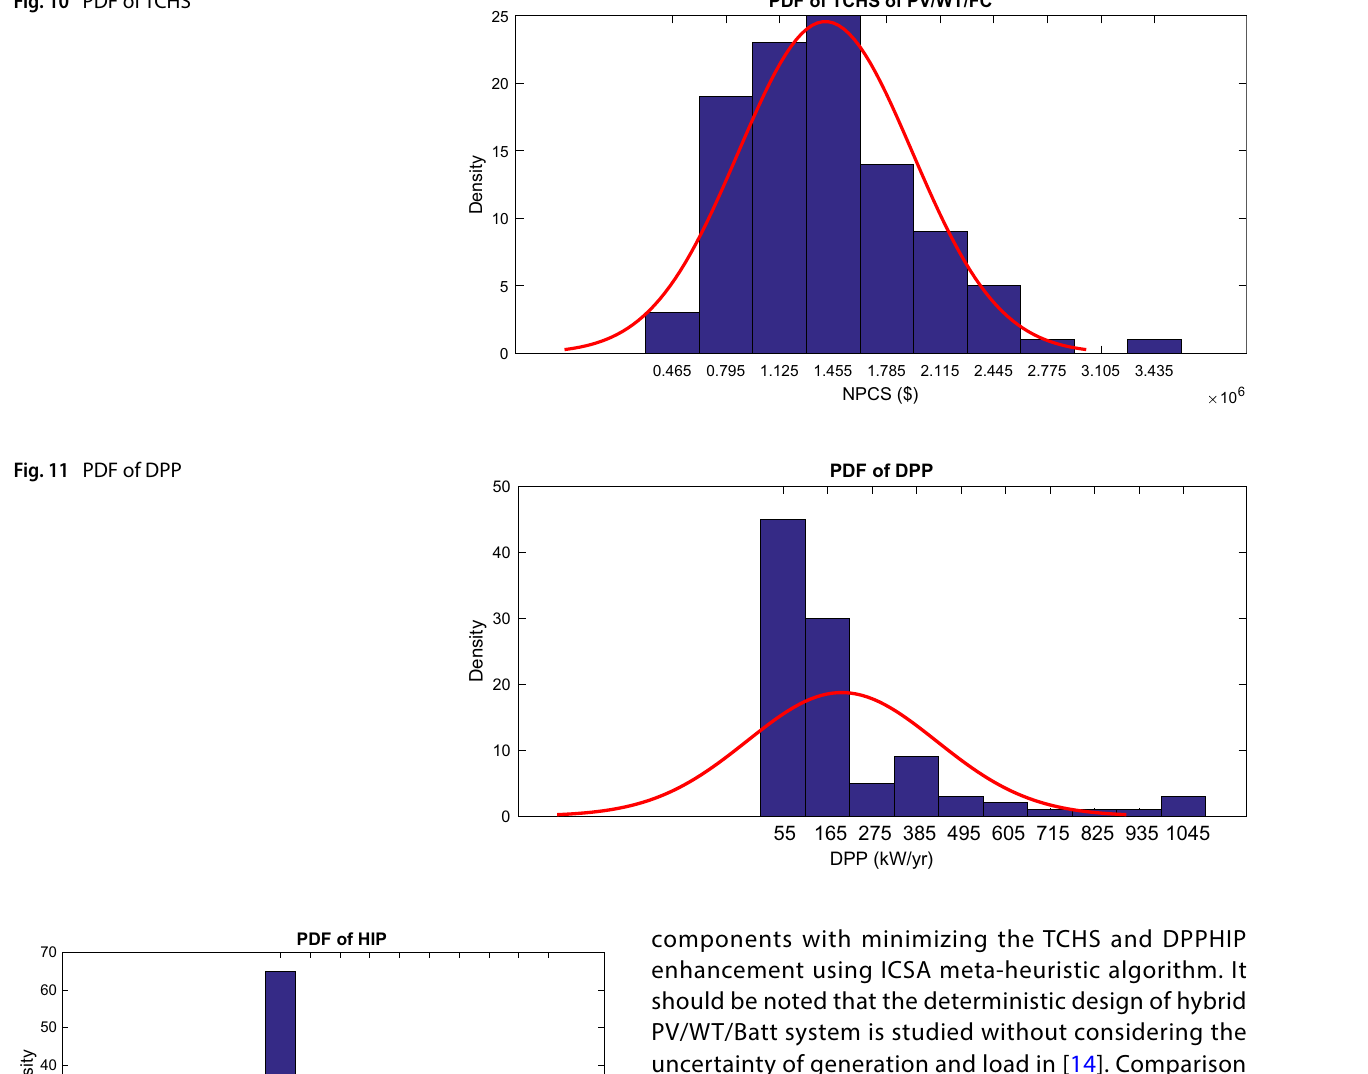
Fig. 10 PDF of TCHS